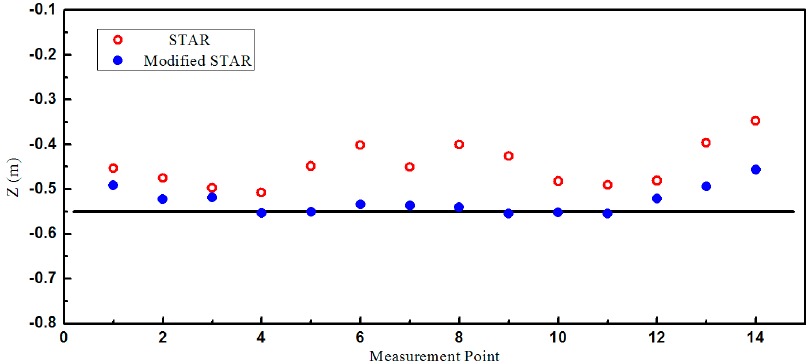
Figure 9. The estimated position of test specimen on the Z-axis. Table 2. The RMS of Localization Errors.